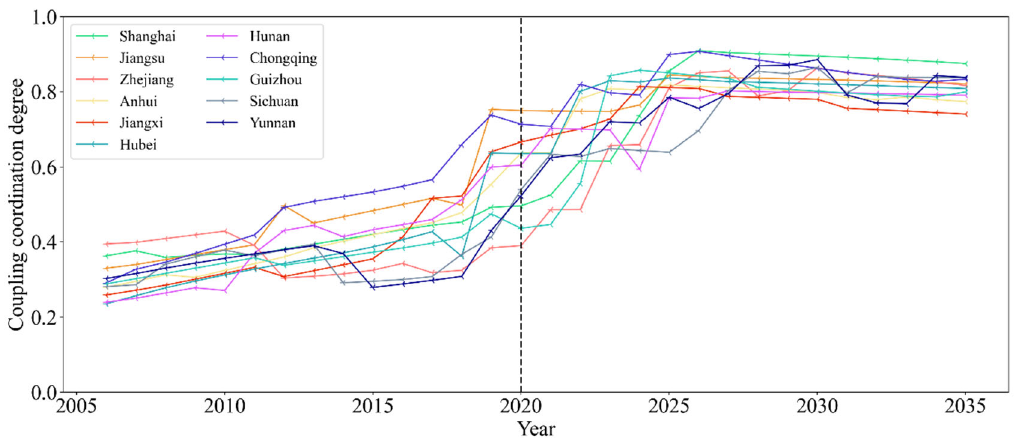
Figure 7. The trend of CCD of 11 provincial administrative regions of the YREB .